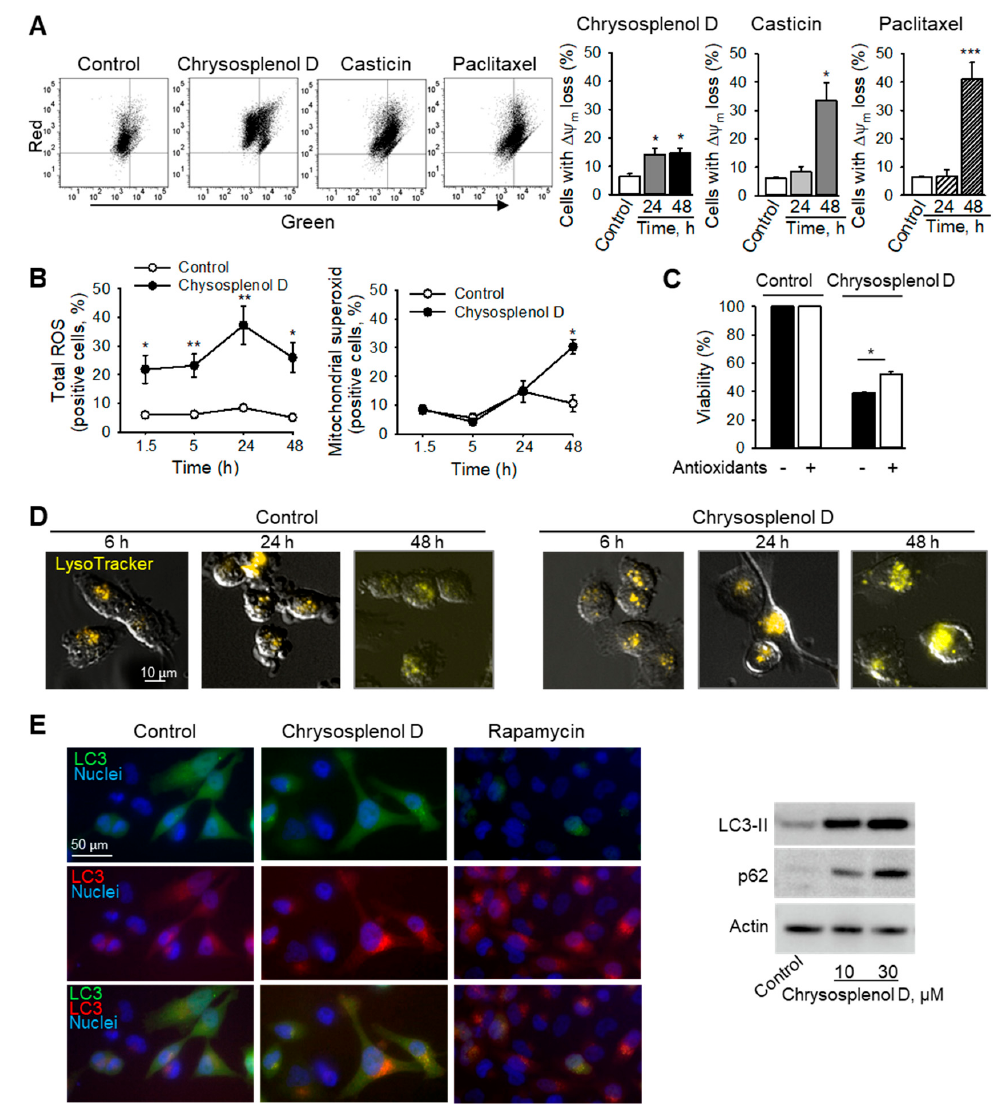
Figure 6. Chrysosplenol D induces ROS, causes dissipation of the mitochondrial membrane potential ( ΔΨ m ), and increases number and size of acidic organelles in breast cancer cells. ( A ) Loss of mitochondrial membrane potential in MDA-MB-231 cells after treatment with either chrysosplenol D (10 µM), casticin (1 µM), or paclitaxel (100 nM) was analyzed by using flow cytometry after staining with JC-1. Representative dot plots after 48 h are shown (left hand panels). Graphs show statistical analyses (right hand panels). ( B ) Total and mitochondrial ROS were analyzed by using flow cytometry in MDA-MB-231 cells treated with chrysosplenol D (30 µM) with H 2 DCFDA and MitoSOX™ Red, respectively. ( C ) ROS scavengers attenuate the chrysosplenol D -induced toxicity. MDA-MB-231 were pretreated with a mixture of Trolox (100 µM) and mitoTEMPO (10 µM) for 1 h and then treated with chrysosplenol D (10 µM) for 48 h. Cell viability was analyzed by XTT. ( D ) MDA- MB-231 cells were treated with chrysosplenol D (10 µM), stained with LysoTracker and analyzed microscopically. Original magnification 200×. ( E ) Analysis of autophagy. GFP-RFP-LC3 HeLa cells were treated for 4 h and analyzed as in ( D ). Rapamycin (1 µM)—positive control. Western immunoblot shows induction of autophagy in MDA-MB-231 cells treated for 24 h. Data are mean ± SEM, n = 3–4, * p < 0.05, ** p < 0.01, *** p < 0.001 vs controls. 2.7. Chrysosplenol D Activates ERK1/2